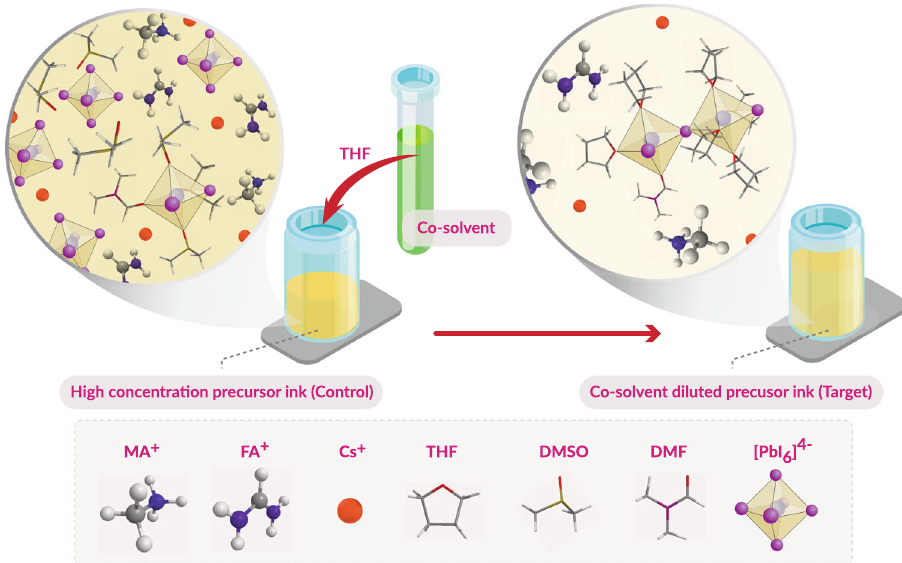
Fig. 1 Schematic illustration of the co-solvent dilution strategy for perovskite deposition. Dilution of perovskite precursor inks by a cosolevnt, top part of the panel: schematic illustration of the dilution process using tetrahydrofuran as a cosolvent. Bottom part of the panel: chemical compounds and their structure employed in the precursor solution.